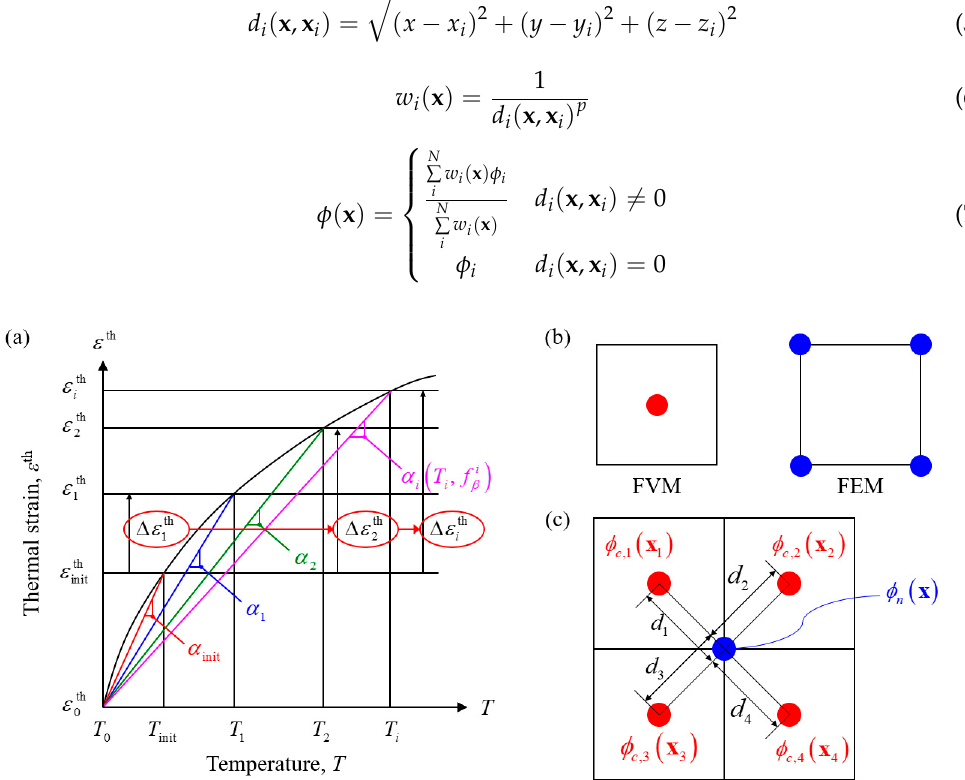
Figure 7. Definition of thermal expansion and the IDW method. ( a ) Determining thermal strain by the incremental concept. ( b ) Computational points of FVM ( left ) and FEM ( right ). ( c ) Distance between FVM and FEM points in IDW method.